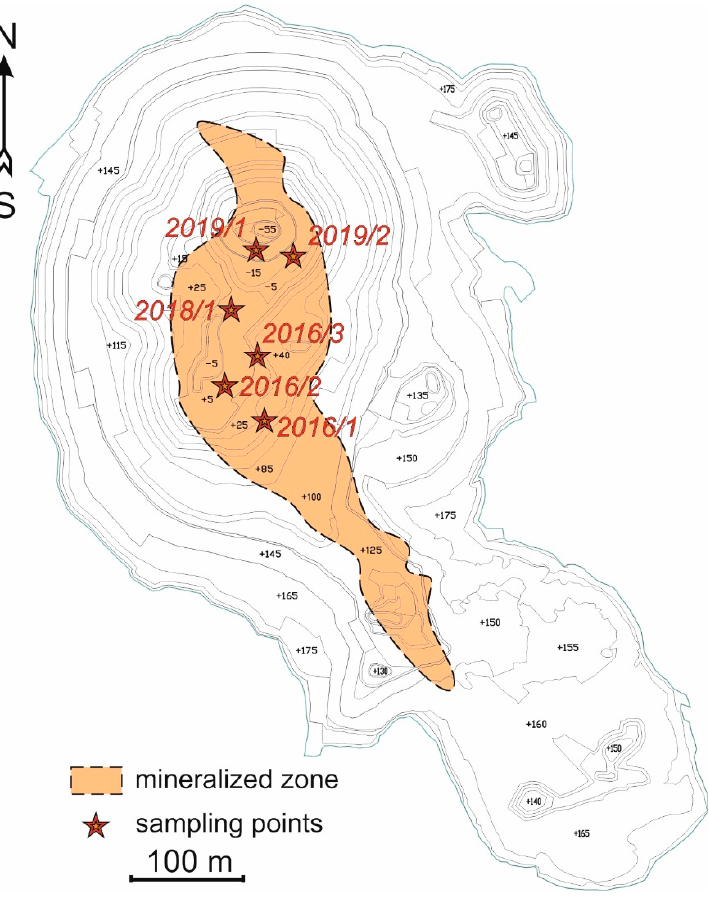
Figure 3. Location of sampling at the Northern quarry of Vorontsovsky deposit. First, digit means the year of collecting, second—the number of sampling point. To obtain native gold concentrates, two large samples weighing 35 kg were taken from areas richest in realgar and orpiment breccia fragments. The samples were crushed to a fraction of less than 1 mm and enriched with a KR-400 centrifugal concentrator. Grains